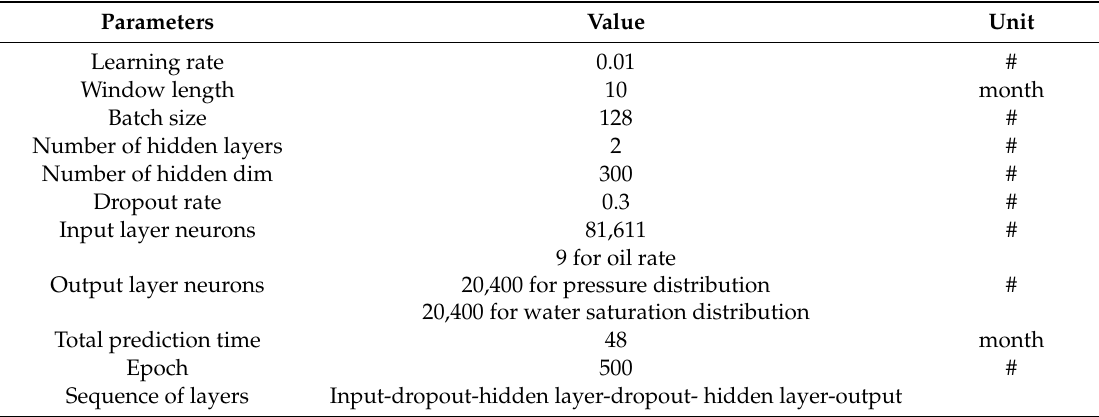
Table 4. Parameters for model training utilizing LSTM network.